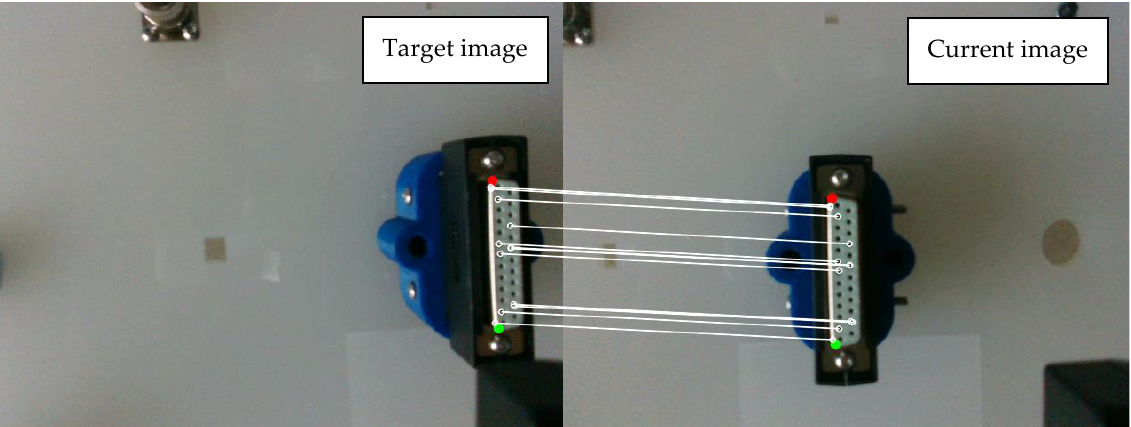
Figure 24. Visual servo based on ORB method (good match).